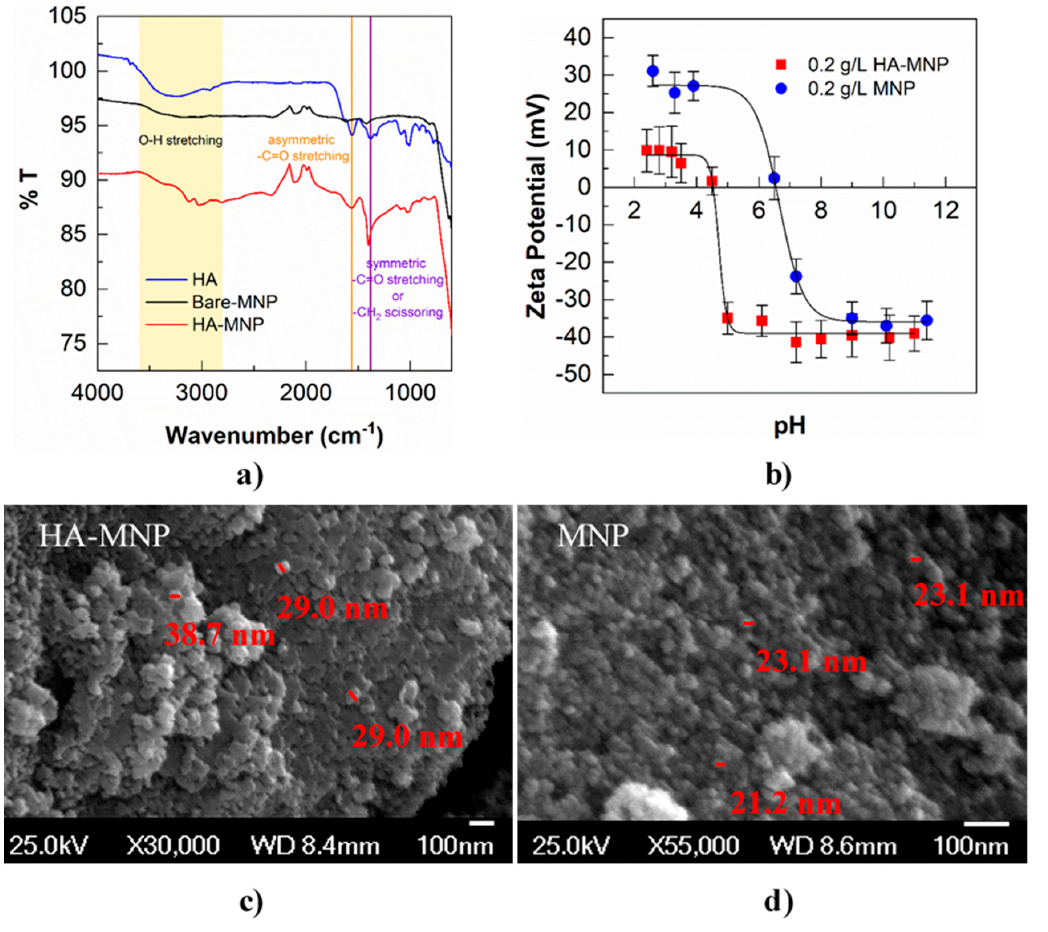
Figure 2. ( a ) FTIR spectra of HA, HA-MNP, and MNP; ( b ) Zeta potential of HA-MNP and MNP; error bars represent the standard deviation of triplicate measurements; ( c ) and ( d ) Field emission SEM images of HA-MNP and